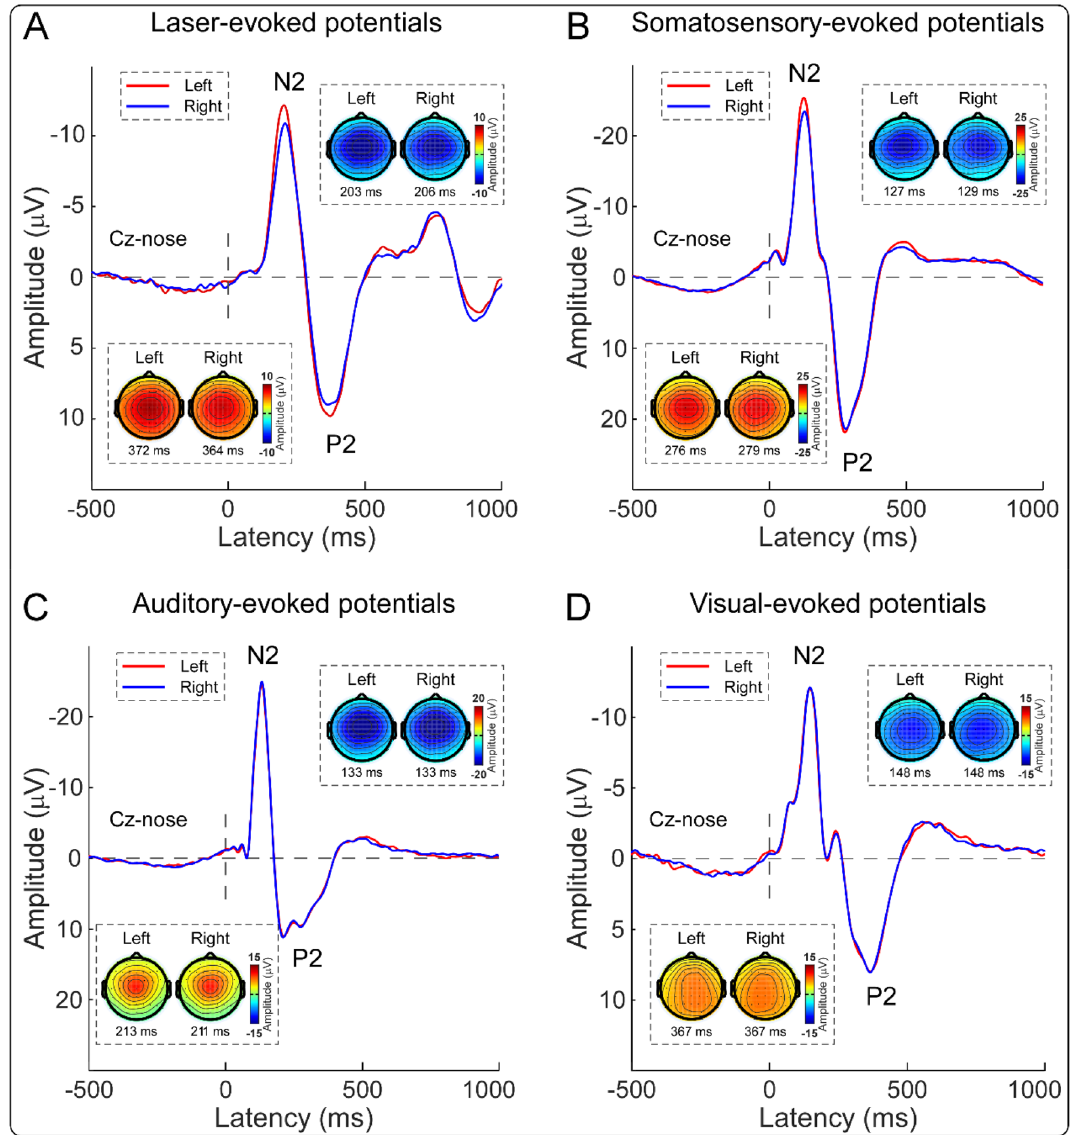
Figure 3. Group-level ERP waveforms and scalp topographies of N2–P2 vertex potentials elicited by nociceptive somatosensory, non-nociceptive somatosensory, auditory, and visual stimuli. Group-level ERP waveforms (Cz-nose) and scalp topographies of the N2 and P2 waves elicited by nociceptive somatosensory, non-nociceptive somatosensory, auditory, and visual stimuli delivered to the left (red lines) and right (blue lines) sides are displayed from ( A – D ). Whereas the N2–P2 amplitudes evoked by non-nociceptive somatosensory, auditory, and visual stimuli were not significantly different between left and right sides, the N2–P2 amplitude evoked by nociceptive somatosensory stimuli that were delivered to the left side was significantly larger than to the right subjects 17,30,31 . However, the reasoning underlying this challenge may not hold, since both right-handed and left-handed subjects are living in a predominantly right-hand society 17,32,40 , and use-dependent changes of the thermal and mechanical properties of the skin and the underlying tissues of the dominant hand would not be equal for both types of subjects. Second, at the central level, it has been interpreted that the laterality of sensitivity to detect transient noci- ceptive stimuli would be associated with the greater involvement of the right brain hemisphere in processing negative emotions and aversive states than the left brain hemisphere 30,45 . This interpretation suggested that the greater sensitivity of the non-dominant (left) hand to nociceptive somatosensory stimuli would reflect cerebral laterality in the emotional and aversive aspects of pain 17,31,36,38,40 . In addition, regardless of the stimulated side of the nociceptive somatosensory stimuli, predominant right hemisphere activation was also observed in some other brain regions, e.g., the thalamus and secondary somatosensory cortex 46 , which are mainly responsible for the sensory/discriminative aspects of pain 41,47 . Both central factors (emotional/aversive and sensory/discriminative